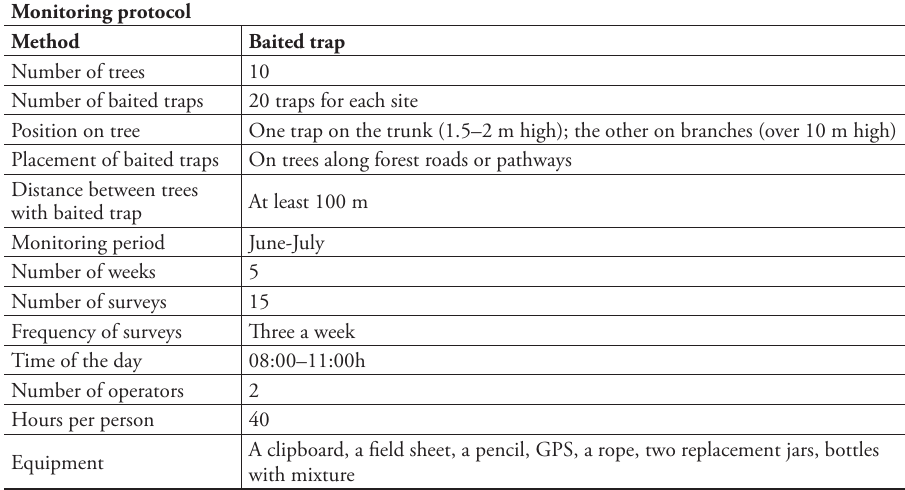
Table 7. Summary of the monitoring protocol for Cerambyx cerdo